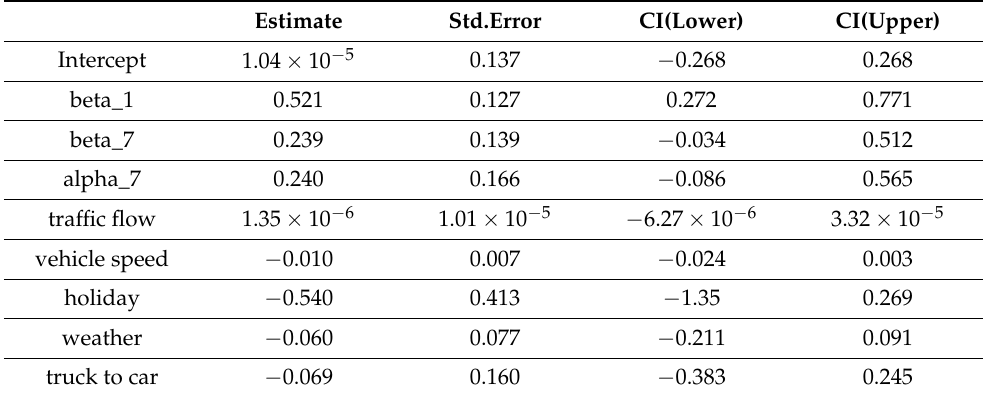
Table 6. Summary statistics for Negative Binomial Model in Soochow